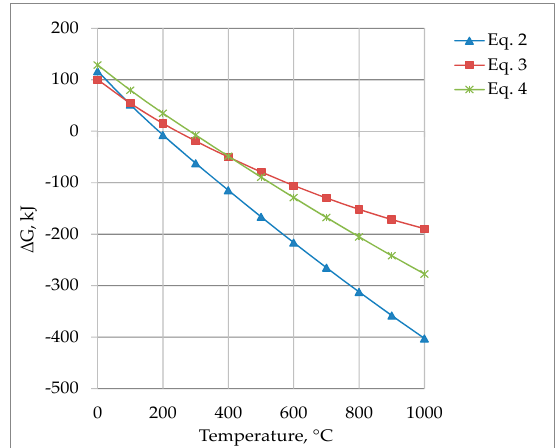
Figure 5. The change in Gibbs free energy ( Δ G) versus temperature for the different possible reactions that take place during the WS 2 synthesis.